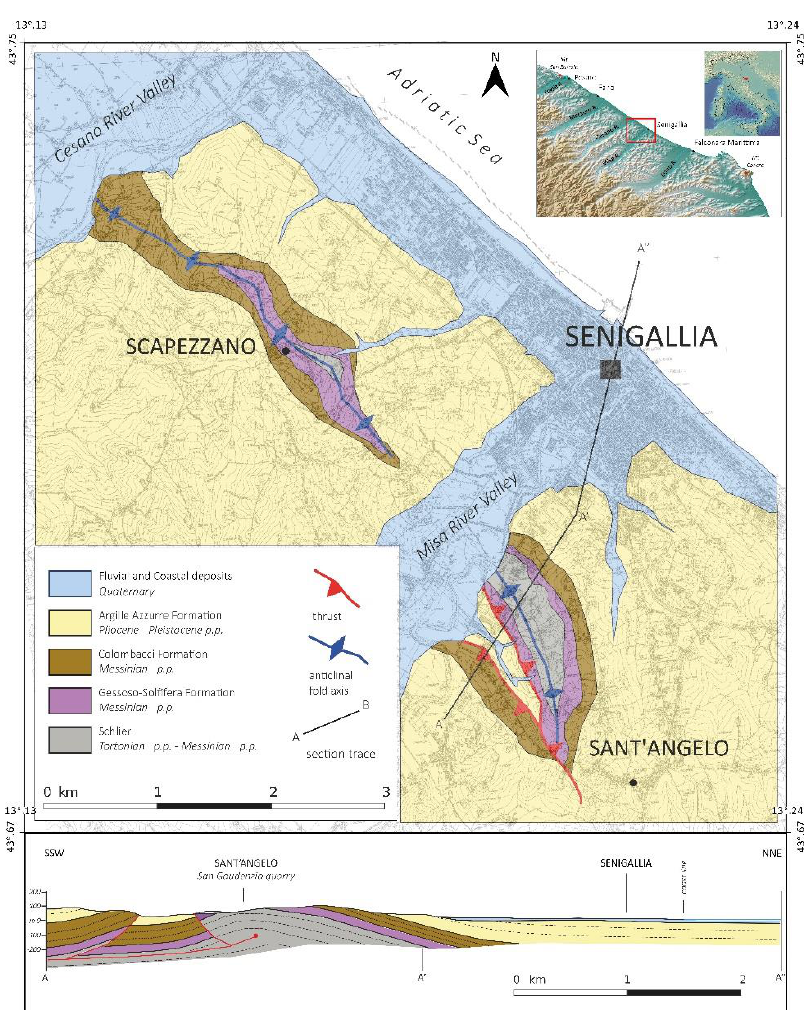
Figure 1. Geological setting scheme of the Senigallia area with geological cross-section and location map. Base data modified from CARG (Geological Cartography of Italy) [4].